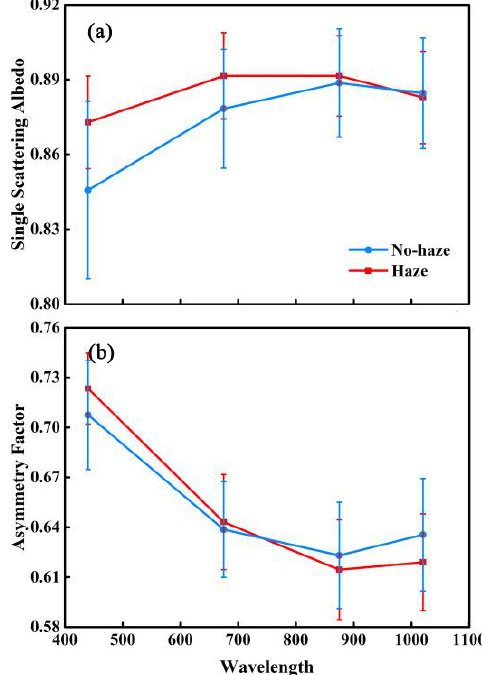
Figure 5. Changes of mean (a) single scattering albedo and (b) asymmetry factor during winter haze